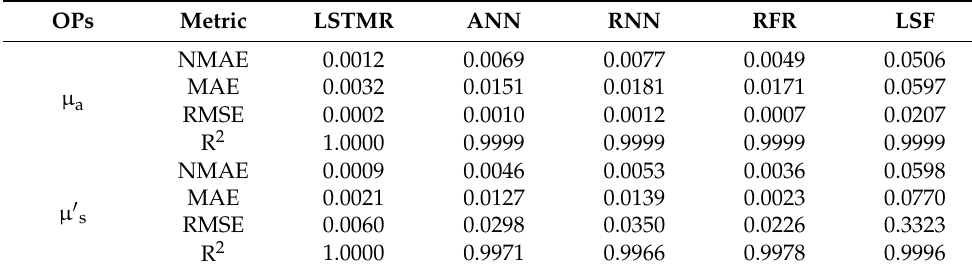
Table 2. Predictive performance of different mapping models in simulation